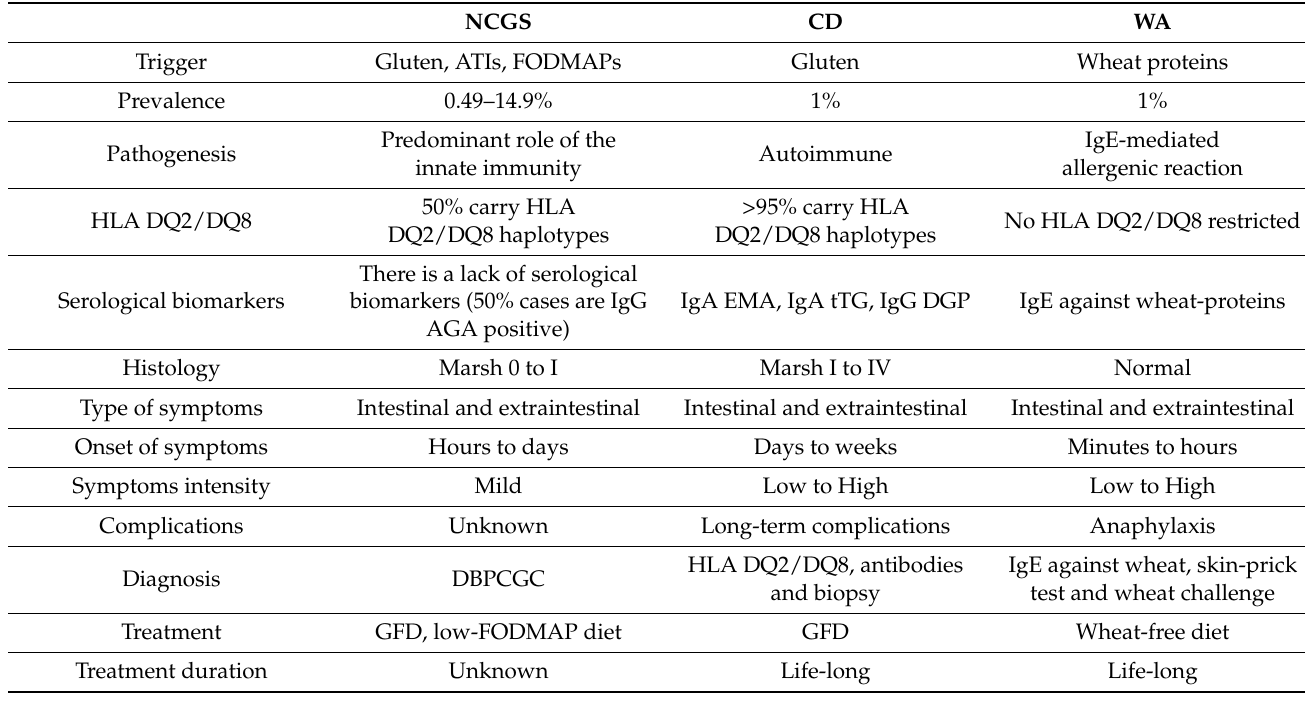
Table 3. Comparison among gluten-related disorders